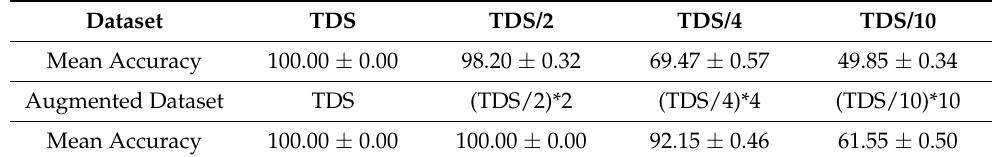
Table 17. Performance comparison; TDS is the dataset where 400 graphs are for training and 200 graphs for testing. The Numerical Augmentation ratio is Dataset × Augmentation-Scale.